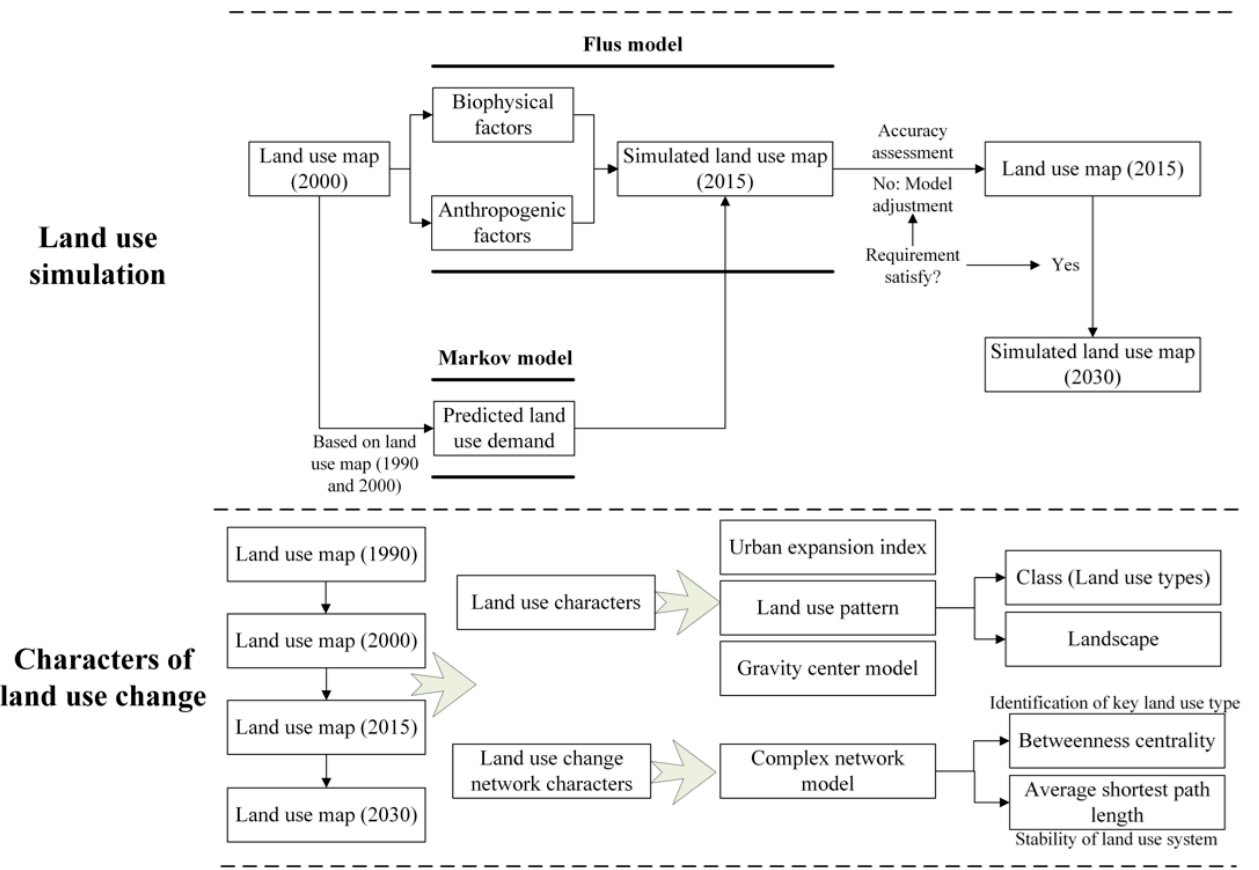
Figure 3. Methodology flow chart.